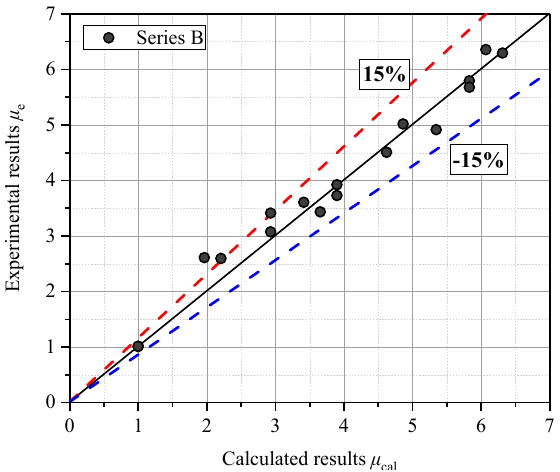
Figure 16. Comparison of experimental data and calculated results by Equation (5) in this research.